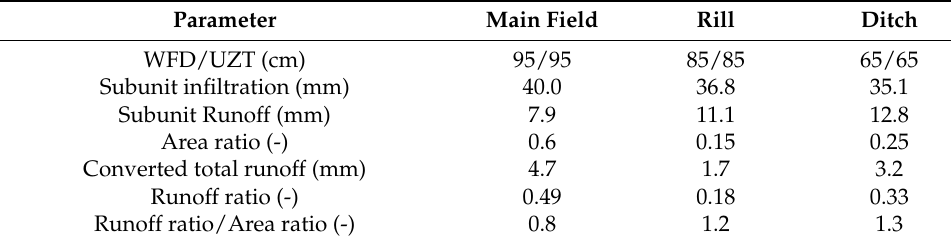
Table 8. Statistics of three kinds of topographic subunits in 20160406 runoff case.